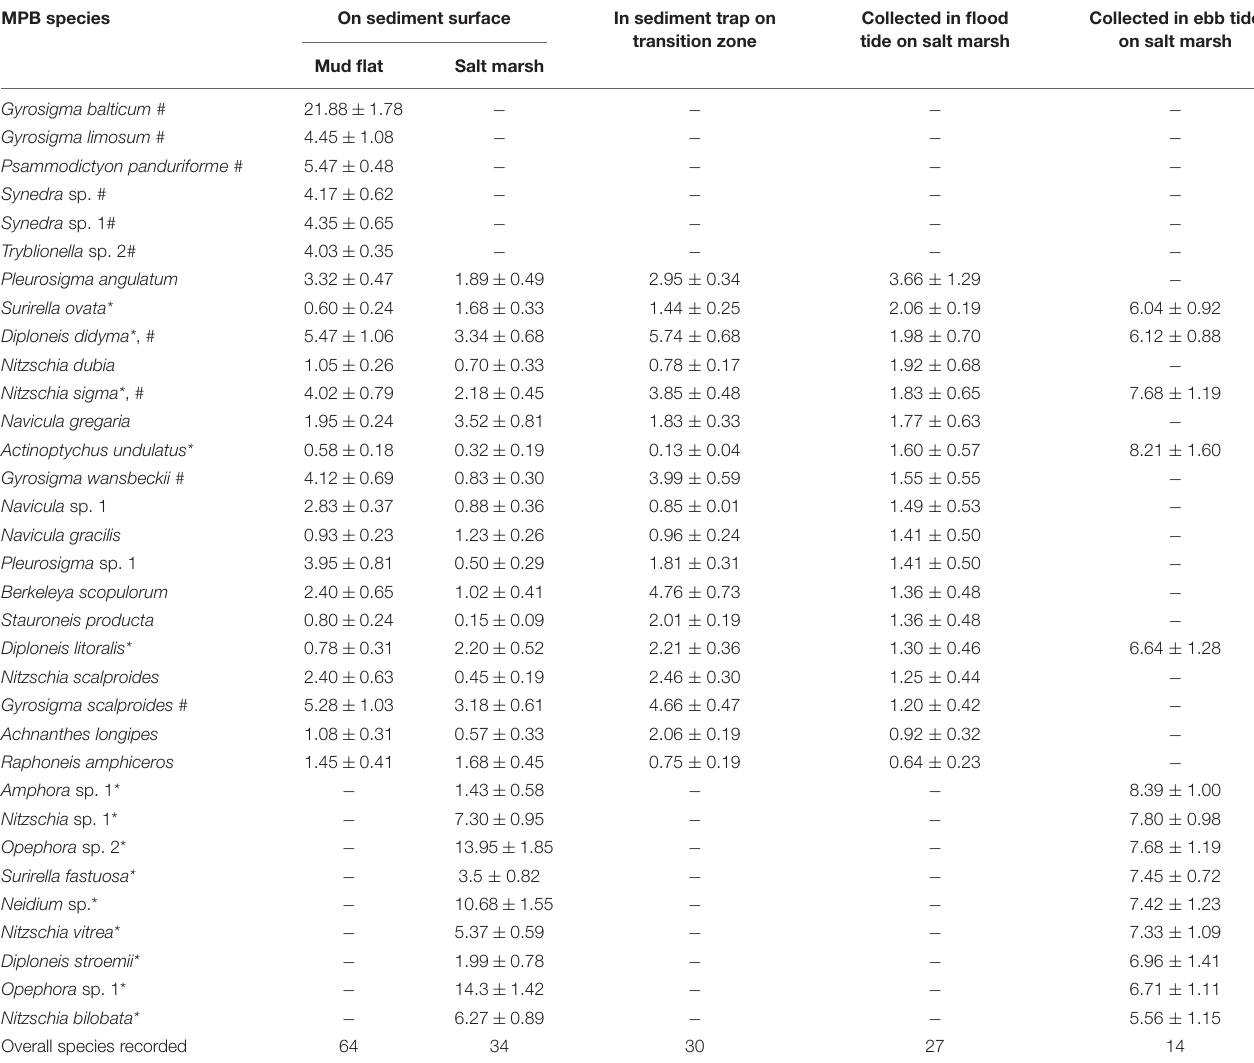
TABLE 3 | Relative abundance ± SE (%) ( n = 8) of MPB diatom species present in mudflat and salt marsh sediments and sampled in sediment traps and in flood and ebb-tide water at Fingringhoe Wick, Colne Estuary, Essex, United Kingdom. MPB